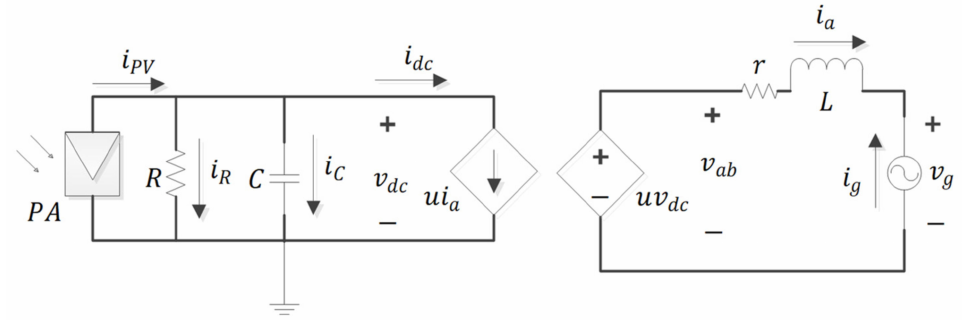
Figure 4. Representation of the switched